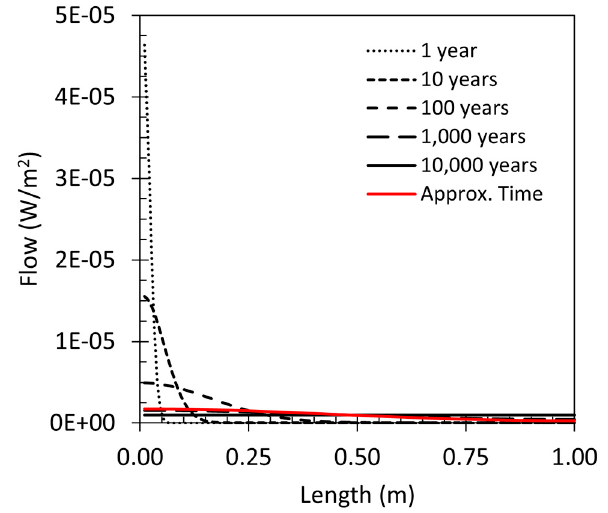
Figure 6. Flow rate along the length of the sample from time intervals of 1 year to 10,000 years. B) Zoomed-in flow rates from 100 years to 10,000 years to show the transition from transient to steady-state flow.